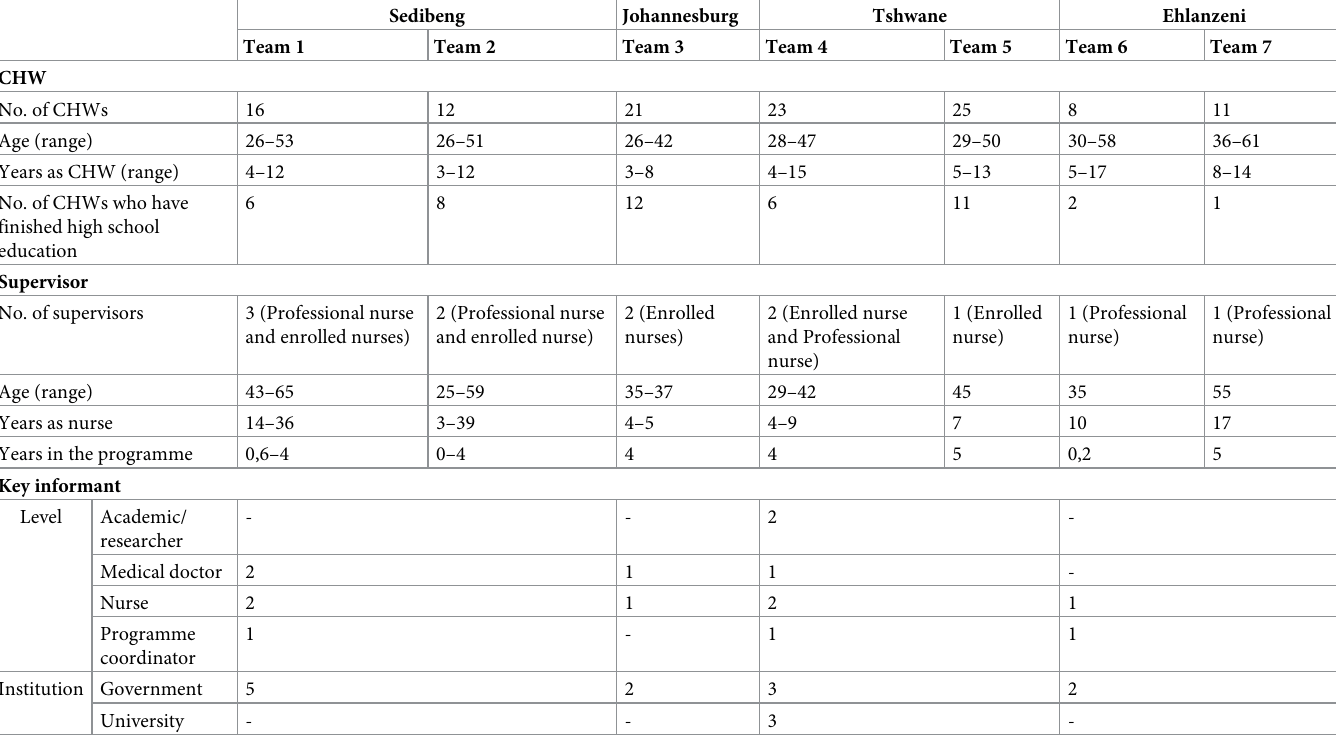
Table 4. CHWs, supervisors and key informant sociodemographic